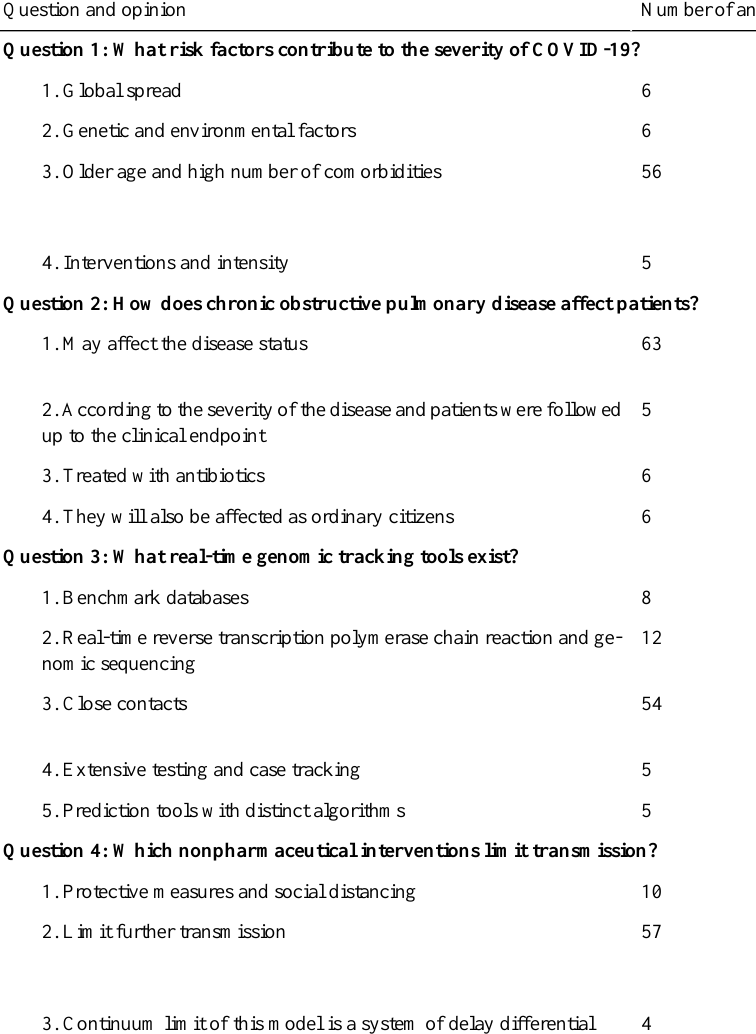
Top words in answersNumber of answers a Question and opinion